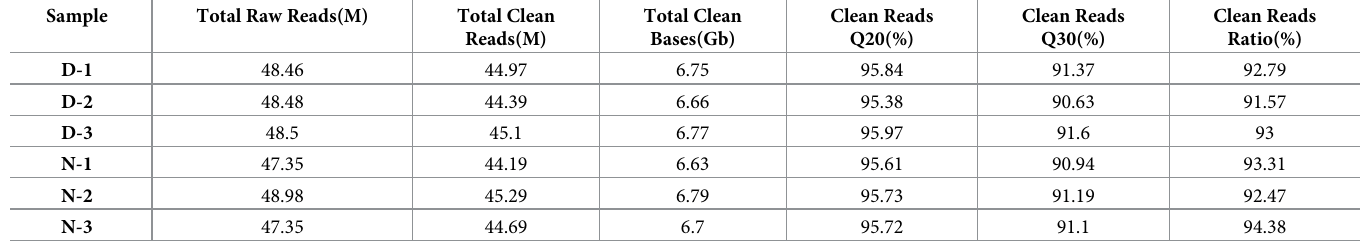
Table 1. Summary of sequencing reads after filtering. D-1, D-2 and D-3 are three biological repeats at midday. N-1, N-2 and N-3 are three biological repeat at midnight. Q20: the percentage of bases with a Phred value more than 20; Q30: the percentage of bases with a Phred value more than 30. Sample